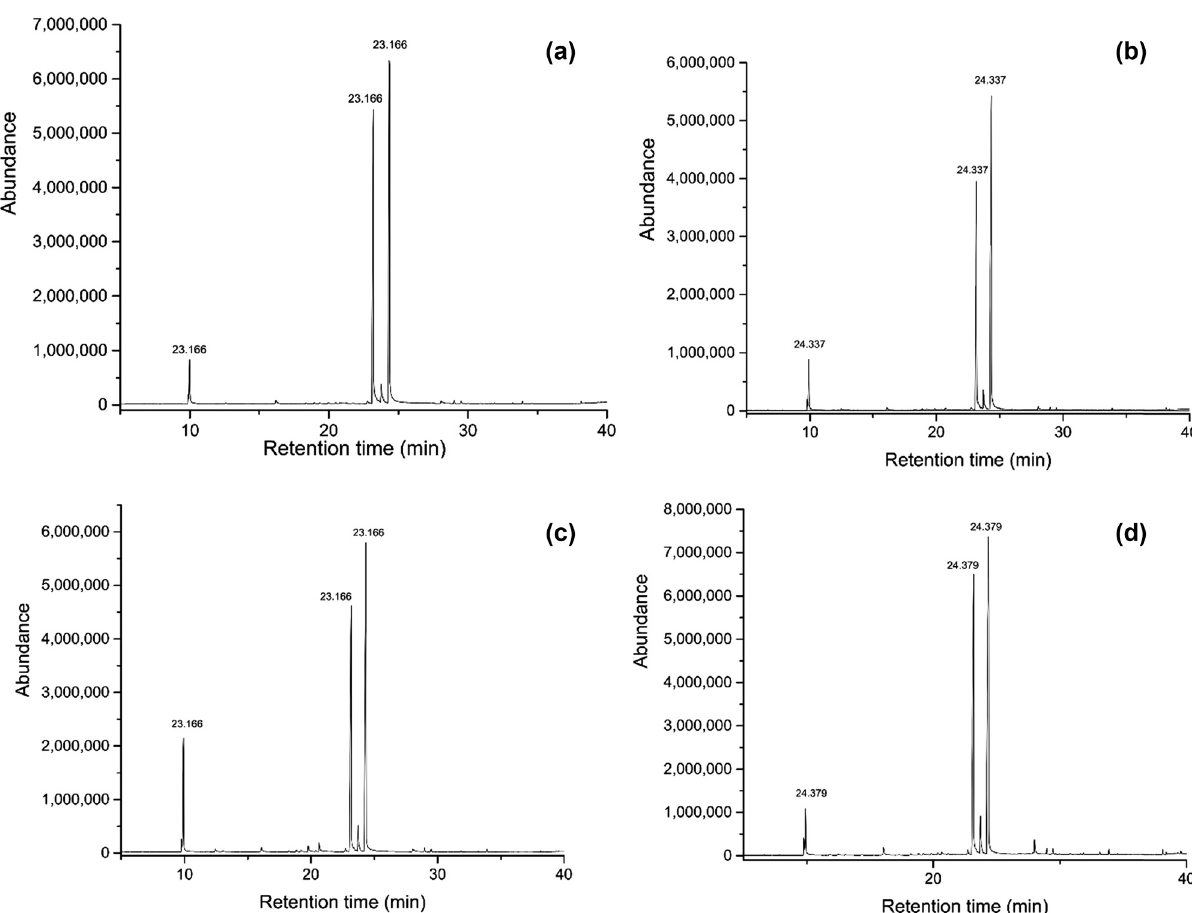
Figure 2: Chromatography of essential oil samples at di ff erent storage conditions: ( a ) initial; ( b ) after 1 week at 45; ( c ) after 1 month at 45; and ( d ) redistilled